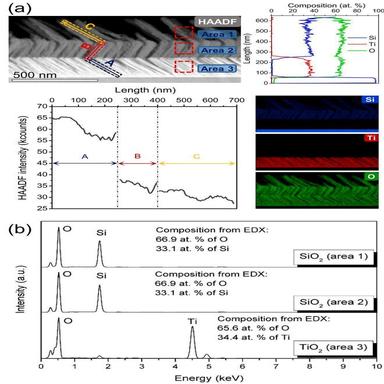
STEM-EDX analysis of a TiO2/SiO2 OAD trilayer deposited at α (TiO2) = 70◦, α (1st SiO2) = 50◦ and α (2nd SiO2) = 82◦ with azimuthal rotation between layers of Φ = 180◦. (a) STEM-HAADF micrograph and elemental maps obtained for Si, Ti and O atoms together with the elemental profiles along the whole coating thickness and the HAADF profile collected along individual columns of each layer. (b) EDX integrated spectra and associated compositional quantitative analysis for each OAD layer.